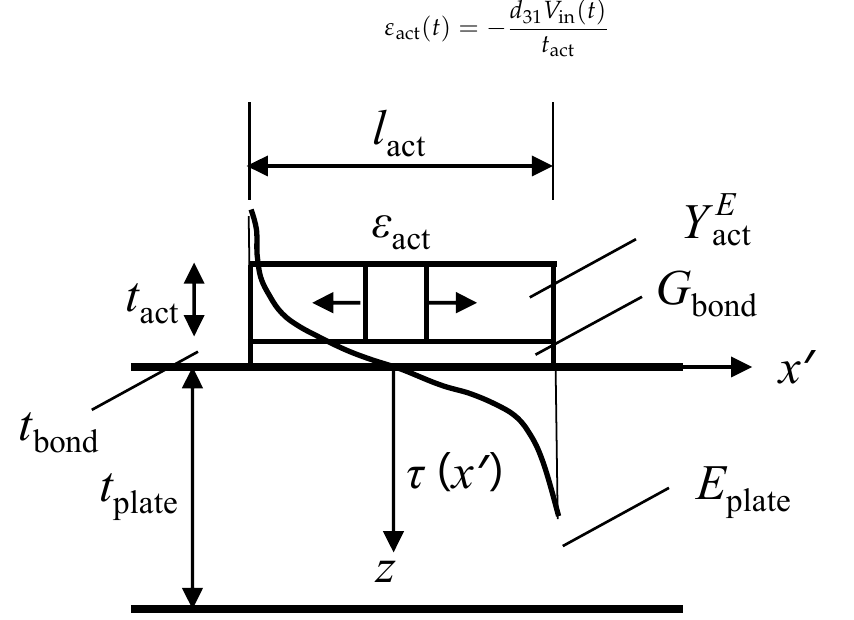
Figure 2. Schematic diagram of LW excitation [35]. Based on the shear-lag model, the stress generated by the PZT coupled to the structure through the adhesive layer is shown in Equation (3).